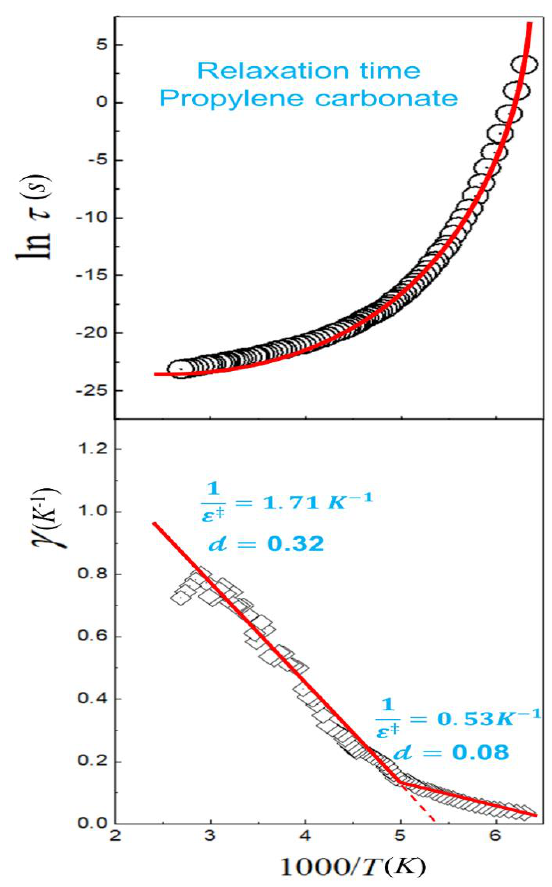
Figure 3. The Arrhenius (upper panel) and Transitivity (lower panel) planes of the temperature dependence of relaxation time of the propylene carbonate. The diamond symbols represent the transitivity values obtained numerically and smoothing with the Savitzky – Golay filter. Red lines emphasize two regions where the temperature dependence of the transitivity is linearized, as expected by the Aquilanti – Mundim law.